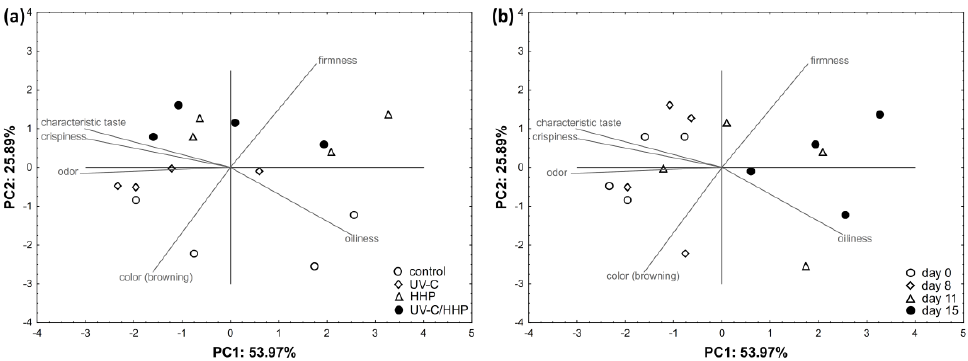
Figure 8. Distribution of fried, fresh-cut potatoes in two-dimensional coordinate system defined by the first two principal components (PC1 and PC2) in relation to the ( a ) treatment and ( b ) storage time.